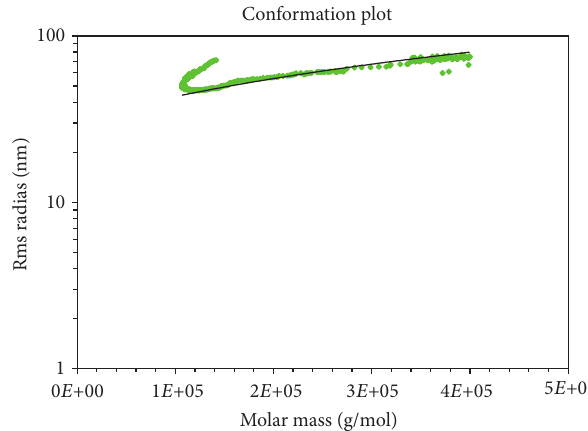
F 3: e relationship between Rg and Mw of KGM.